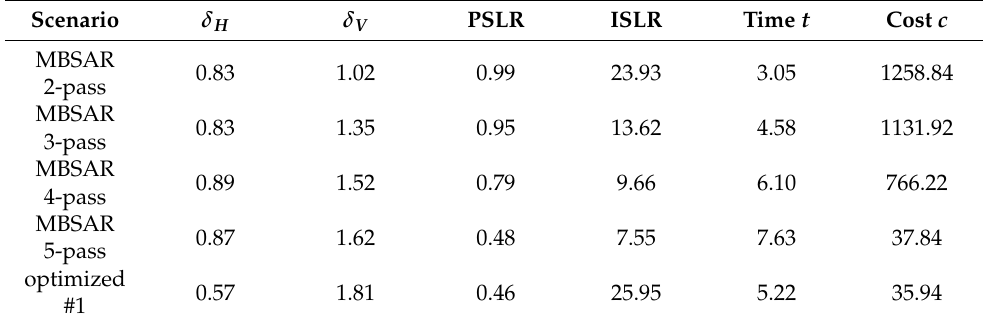
Table 4. Quality parameter comparison for MBSAR trajectories and an optimized